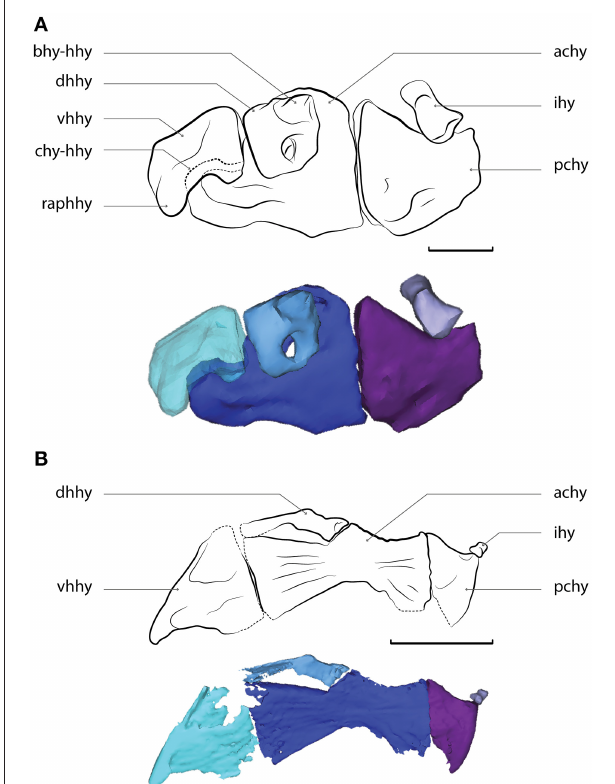
FIGURE 8 | (A) Velifer hypselopterus , MNHN.IC.1982.0025, reconstructed from virtual tomographic data. Ventral portion of the left hyoid arch, in medial view, reversed (anterior faces left). (B) Stylephorus chordatus , MNHN.IC.2004.1317, reconstructed from virtual tomographic data. Ventral portion of the left hyoid arch, in medial view, reversed (anterior faces left). Abbreviations: achy, anterior ceratohyal; bhy-hhy, facet of the basihyal-dorsal hypohyal articulation; chy-hhy, condyle of the anterior ceratohyal-ventral hypohyal articulation; dhhy, dorsal hypohyal; ihy, interhyal; pchy, posterior ceratohyal; raphhy, retro-articular process of the ventral hypohyal; vhhy, ventral hypohyal. Scale bar equals 2